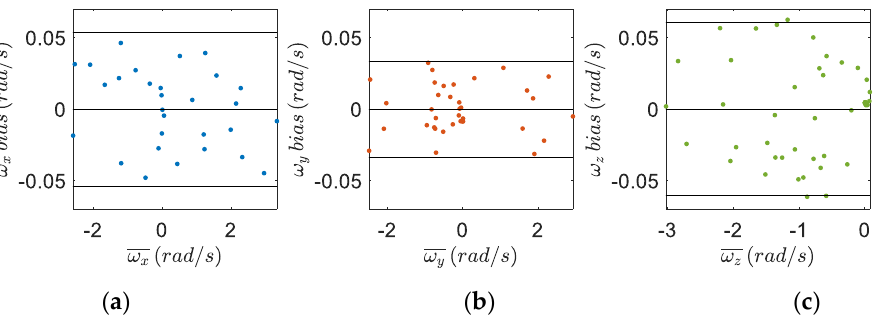
Figure 6. Bland – Altman plots to assess the agreement of the tibial IMU with the commercial, gold standard, Xsens system on the ( a ) x-axis, ( b ) y-axis and ( c ) z-axis of the two accelerometers. The horizontal axis is the average acceleration of the two instruments (i.e., accelerometer units), while the vertical axis is the difference between the two. The solid horizontal lines are the average difference and the limits of agreement.